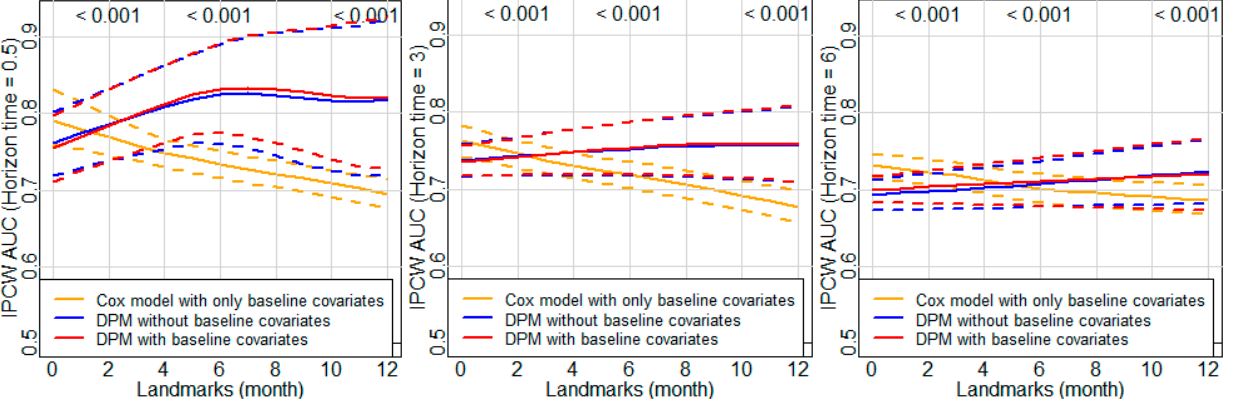
Figure A5. IPCW AUC and its 95% CI for the DPM using time-dependent albumin and ECOG PS assessed at horizon time of 0.5 month (left), 3 months (middle), and 6 months (right). P values at the top of each plot are for comparing the DPM using both time-dependent albumin, ECOG PS, and baseline covariates and the baseline Cox model at landmarks of 2, 6, and 12 months.